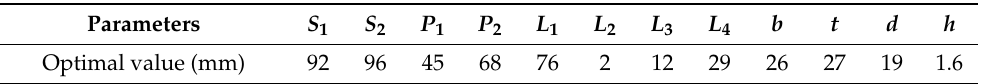
Table 1. The optimal dimension of the inverted L-shaped patch antenna with corner-truncated partial ground plane diagonally adjoined with a square branch (in